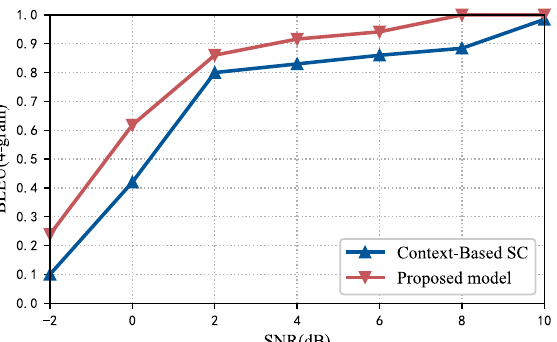
Figure 6. BLEU (4-g) score of our proposed model and context-based SC versus SNR over the AWGN channel.